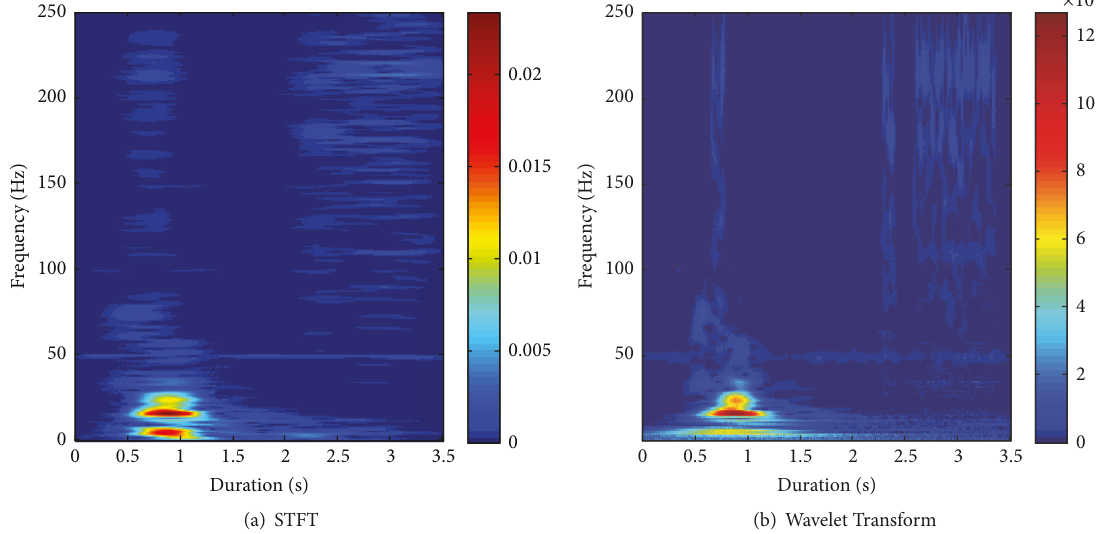
Figure 7: Time-frequency characteristics of the STFT and the Wavelet